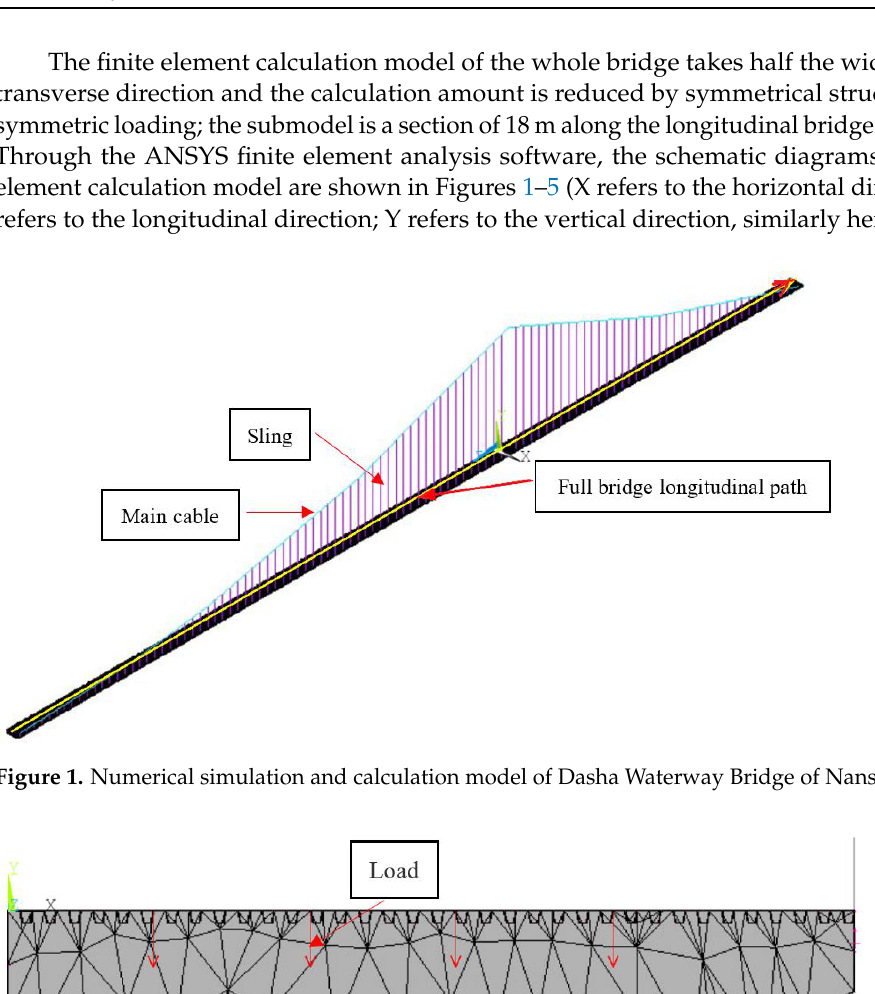
Table 1. Numerical model parameters of bridge deck pavement.